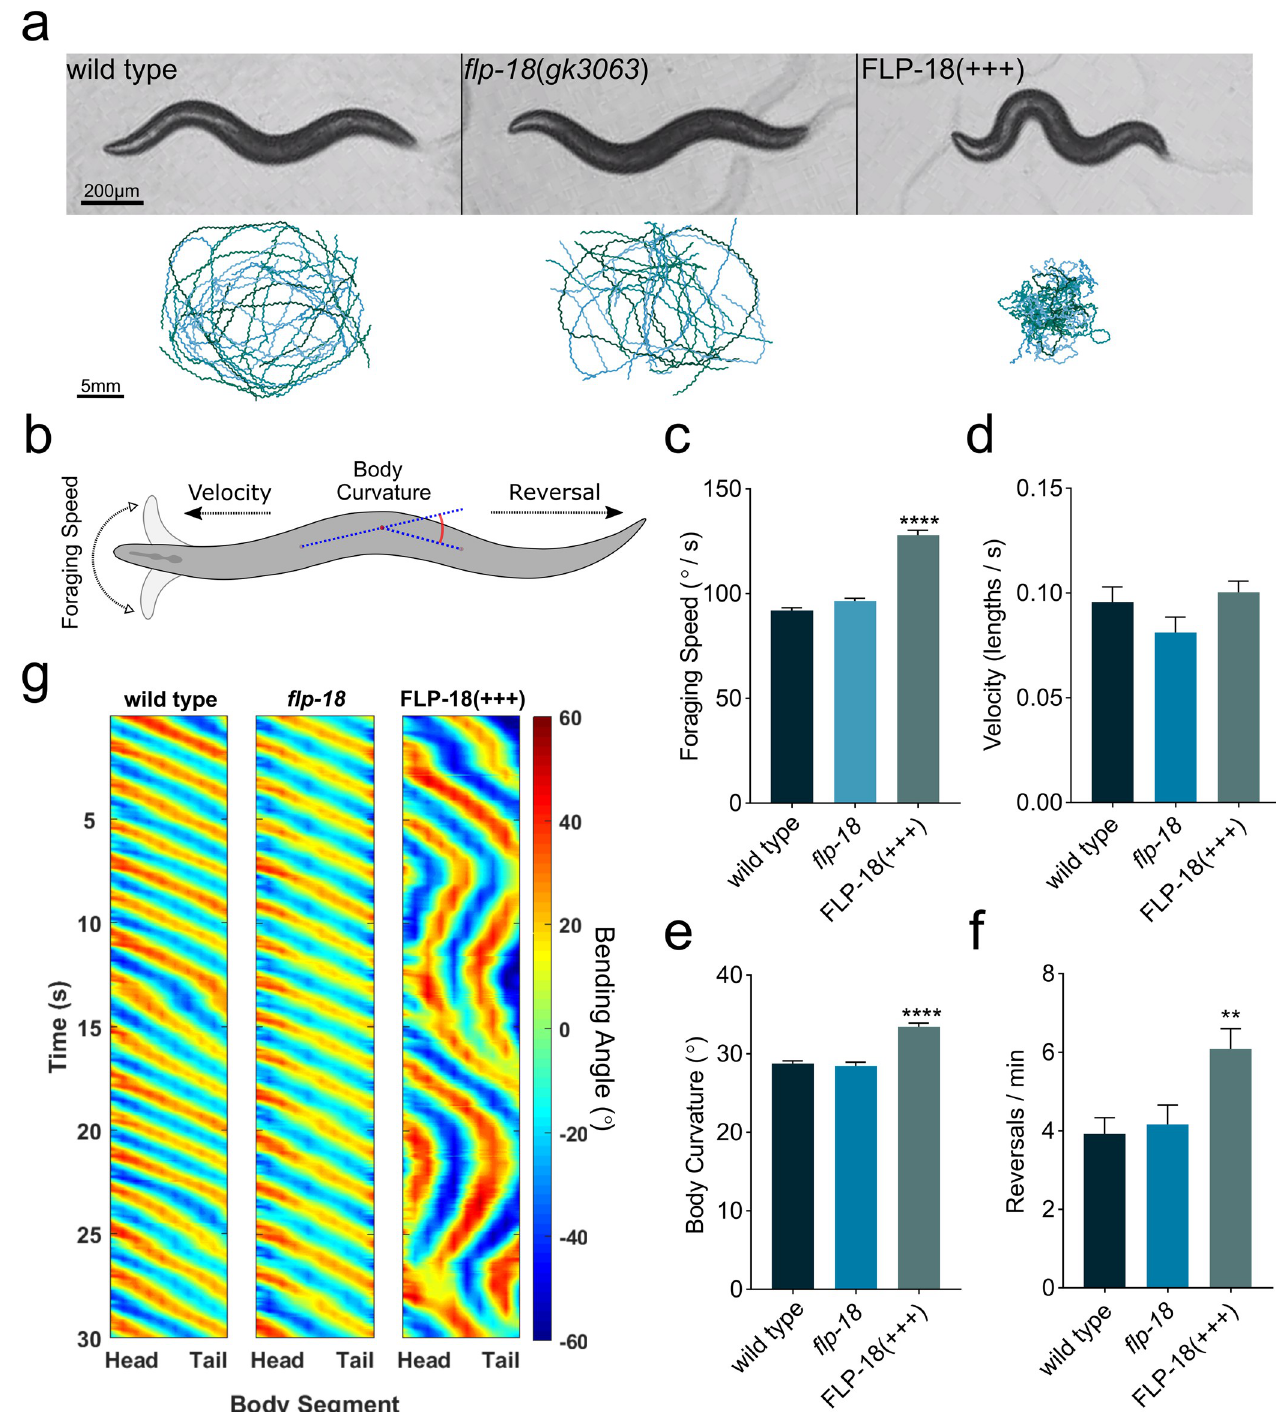
Fig 2. Overexpression of FLP-18 causes locomotion defects. (A) Behavioral tracking of wild type, flp-18(gk3063) mutants, and transgenic animals that overexpress FLP-18 (FLP-18(+++)). Representative images of each genotype (upper panel) and locomotion tracks recorded from multiple animals freely moving on a plate for 5 min (lower panel). Scale bars represent 200 μ m (top) and 5 mm (bottom). (B) Schematic illustrating quantified behaviors. (C-F) Quantification of locomotion behavior. (C) Speed of foraging head movements. (D) locomotion velocity. (E) Body bend curvature. (F) Spontaneous reversal frequency. (G) Kymographs showing body bending along the body over 30 s of locomotion. Color map represents degrees of bending, positive values represent dorsal bends and negative values represent ventral bends. Graphs represent mean ± SEM, significance was calculated using ANOVA with Dunnett’s multiple